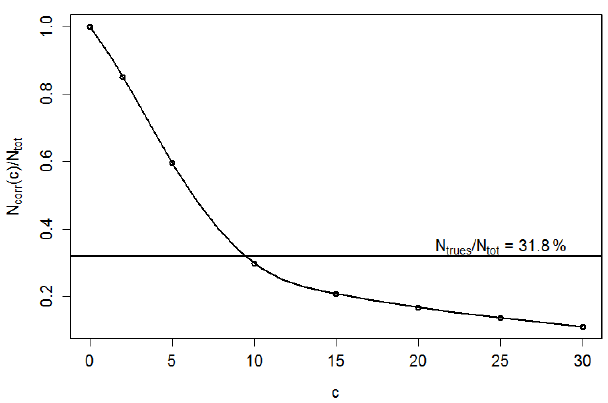
Figure 3. Relative number of scatter corrected coincidences N corr (c)/N tot vs. the scatter calibration factor c . The horizontal ref- erence line was derived from the MC simulation (Fig. 2, Na-22).